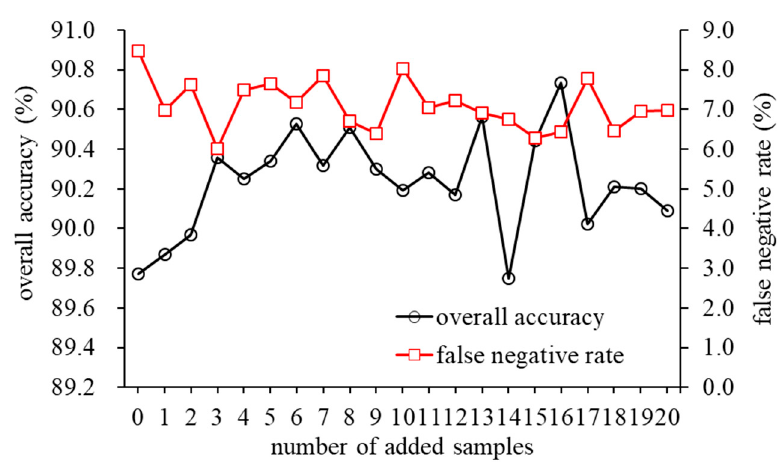
Figure 5. The overall accuracies and false negative rates from the least squares-support vector machine (LS-SVM) for rice false smut (RFS) disease detection in Xiushui based on the model established from Zheliang .